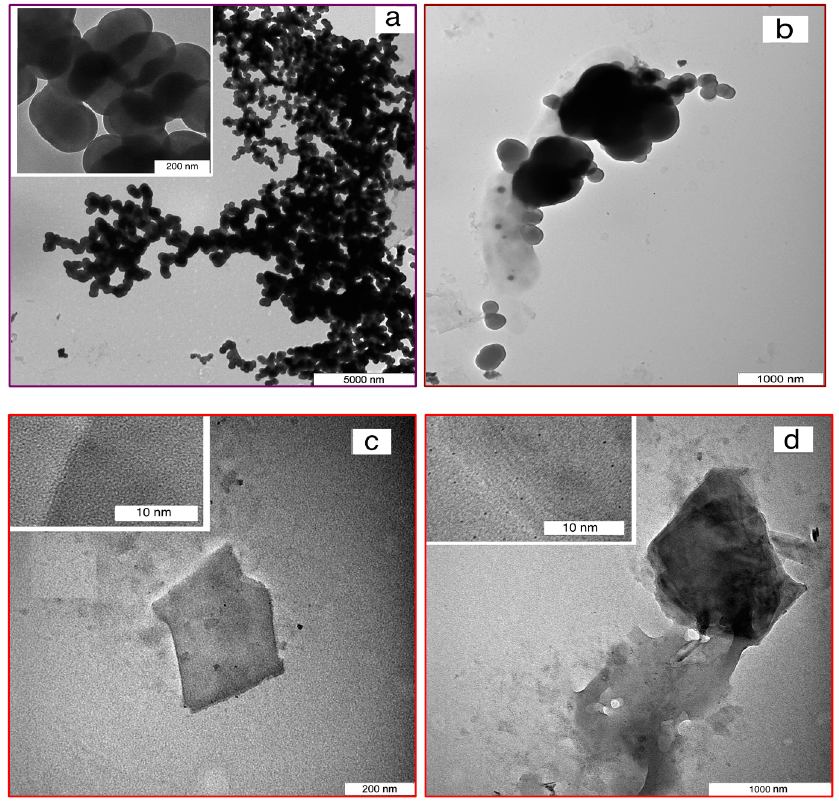
Figure 2. TEM images of ( a ) CNS; ( b ) CNS coated with MLG; ( c ) FLG and ( d ) MLG.